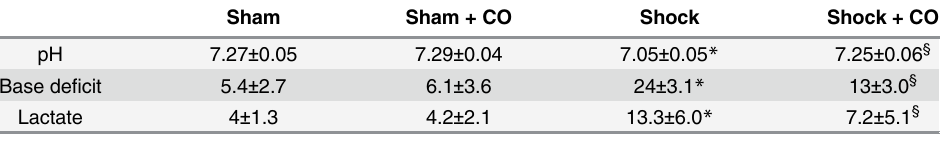
Table 1. Arterial blood gas measurements in mice bled to and maintained at a MAP of 20 mm Hg for 30 minutes with and without inhaled CO (250 ppm). Sham mice underwent anesthesia and surgical manipu- lation without hemorrhage. Mice were bled to a pressure of 20 mm Hg over 15 minutes. CO therapy was started once a pressure of 20 mm Hg was